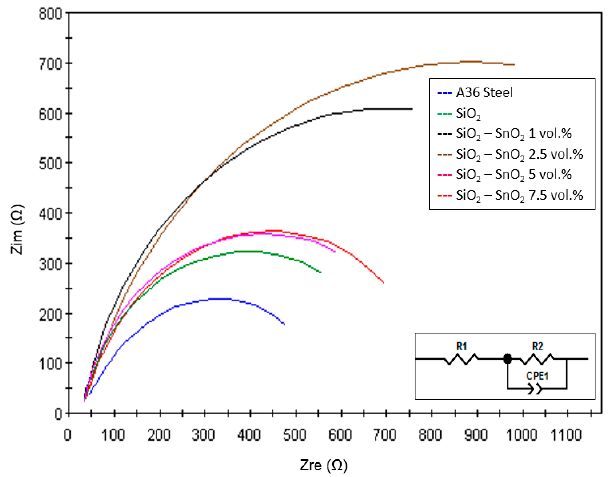
Figure 6. Nyquist plots of the composite coatings in the absence and presence of different concentrations of SnO 2 particles from EIS measurements in NaCl